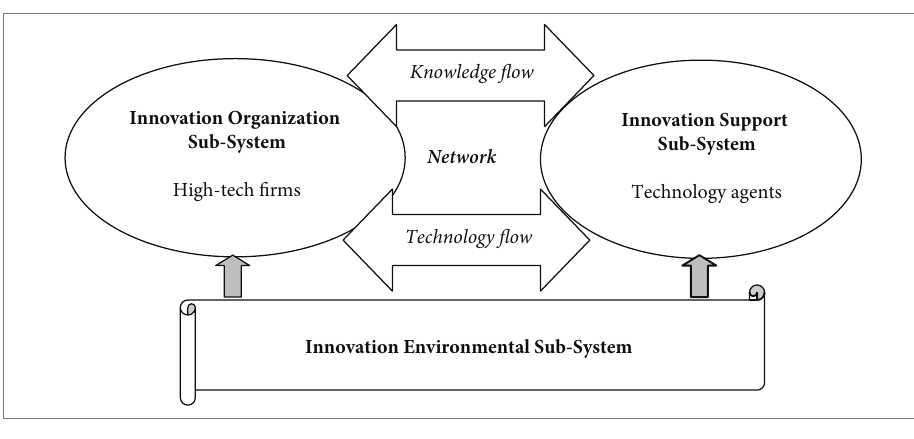
Fig. 1. Innovation System for Science